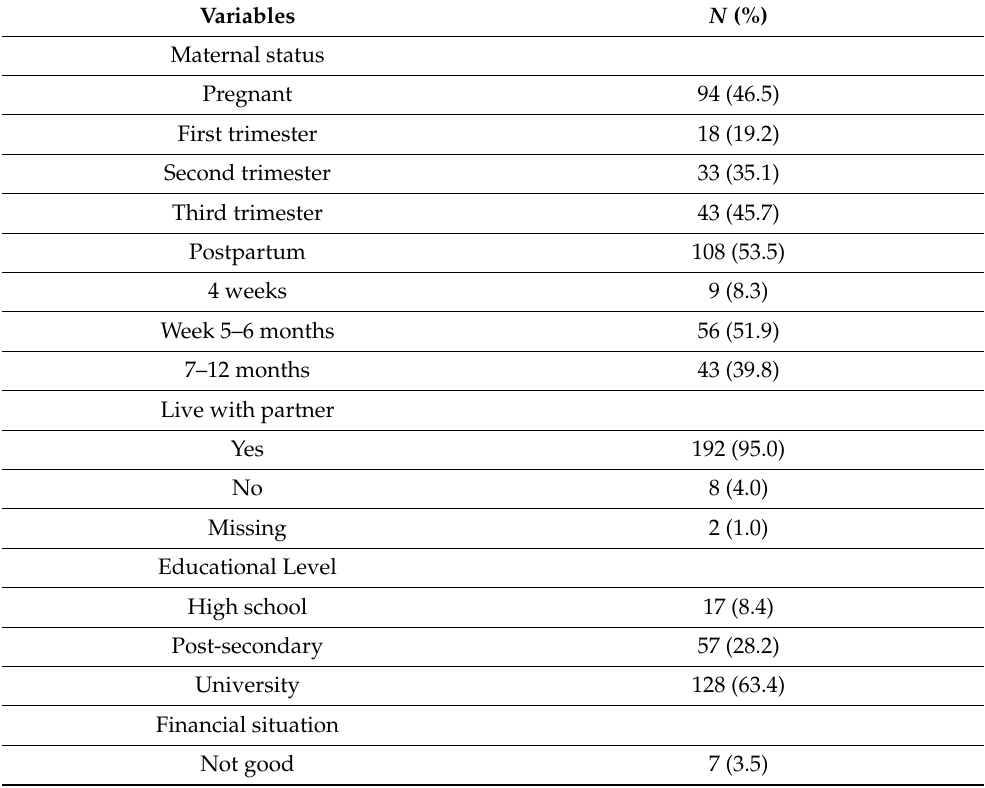
Table 1. Characteristics of participating women ( n =